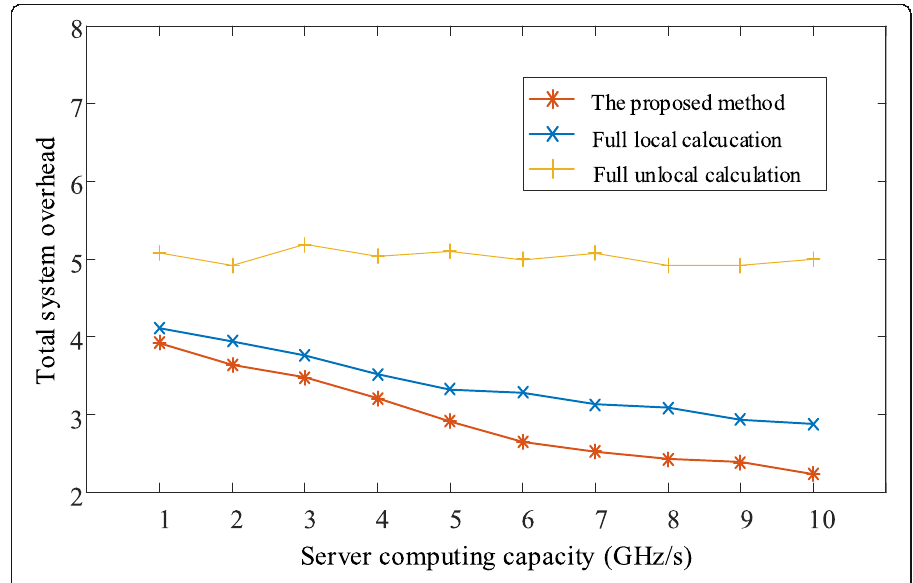
Fig. 4 Relationship between total cost and server computing